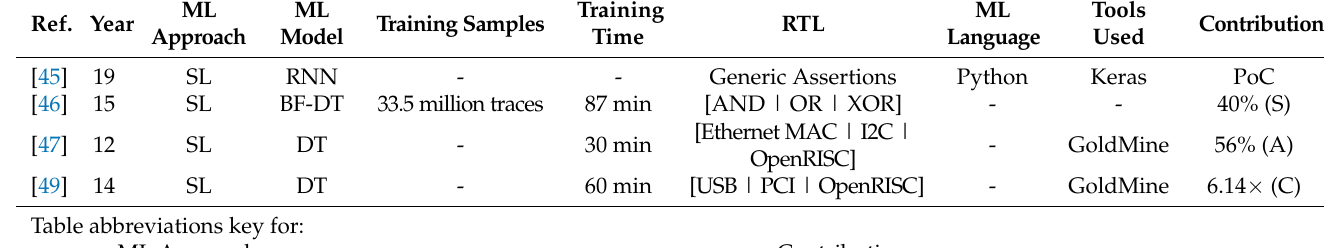
Table abbreviations key for: ML Approach Contribution SL: Supervised Learning